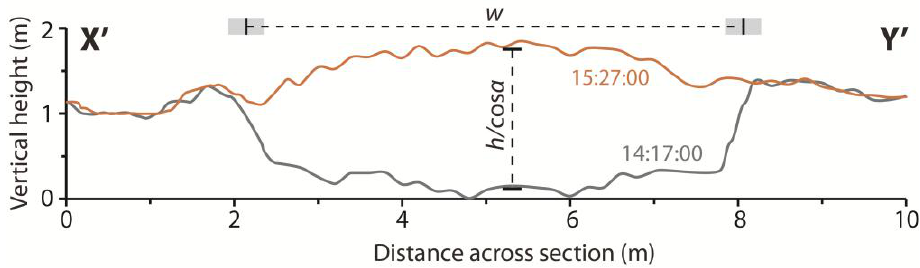
Figure 7. Vertical profiles through two DEMs demonstrating the topographic change due to the advance of the breakout flow lobe down an existing channel. The section is perpendicular to the planimetric direction of flow (Figure 3a) and labelled with the width and height values used to derive viscosity. Grey bars represent the inferred measurement uncertainty, but are too small to be visible in the vertical